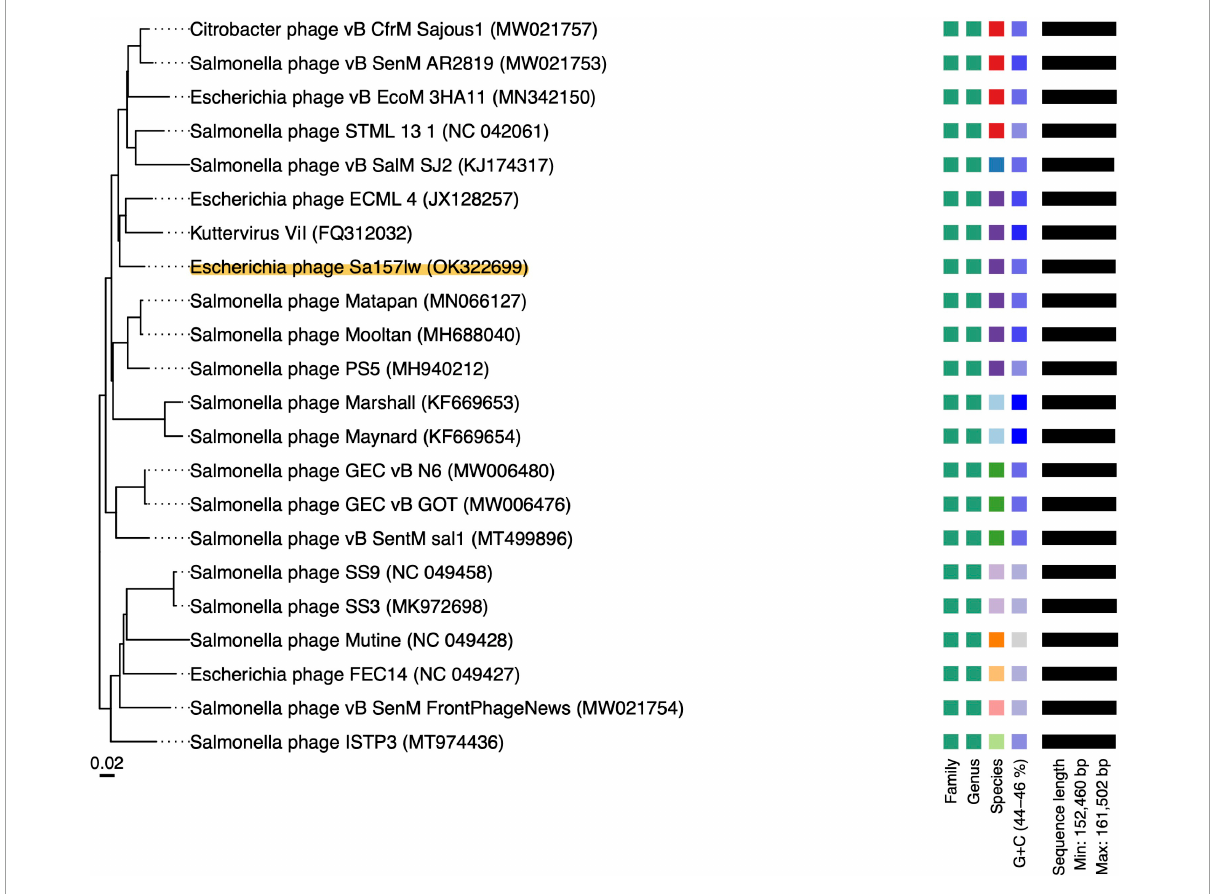
FIGURE1 Phylogenetic analysis of whole-genome sequences of Sa157lw and close-related reference phages belonging to the Kuttervirus genus under the Ackermannviridae family at the amino acid level using VICTOR (formula d6) (https://ggdc.dsmz.de/victor.php). Annotations, including family, genus, and species cluster proposed by VICTOR, genomic G + C content and sequence length, are given to the right-hand site of the tree. The accession number of each phage is provided in the parenthesis.